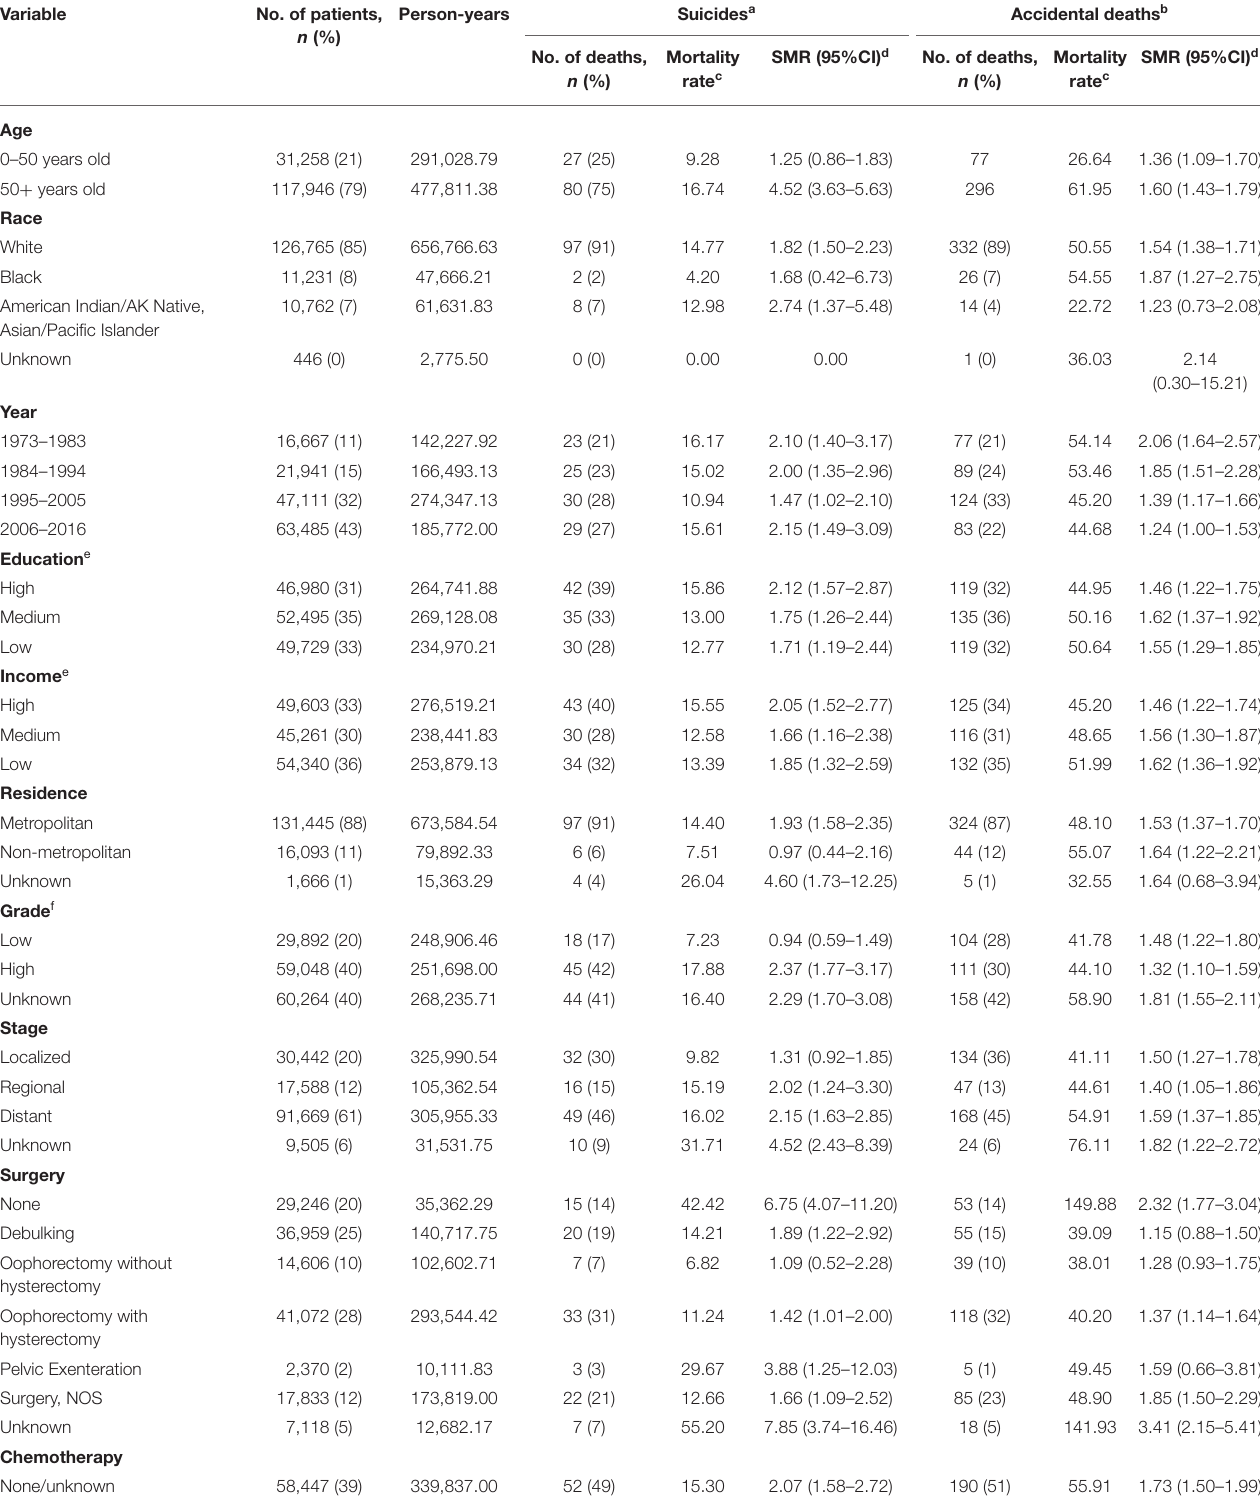
TABLE 1 | The risk of suicide and accidental death among patients with ovarian cancer diagnosed between January 1, 1973 and December 31, 2016.